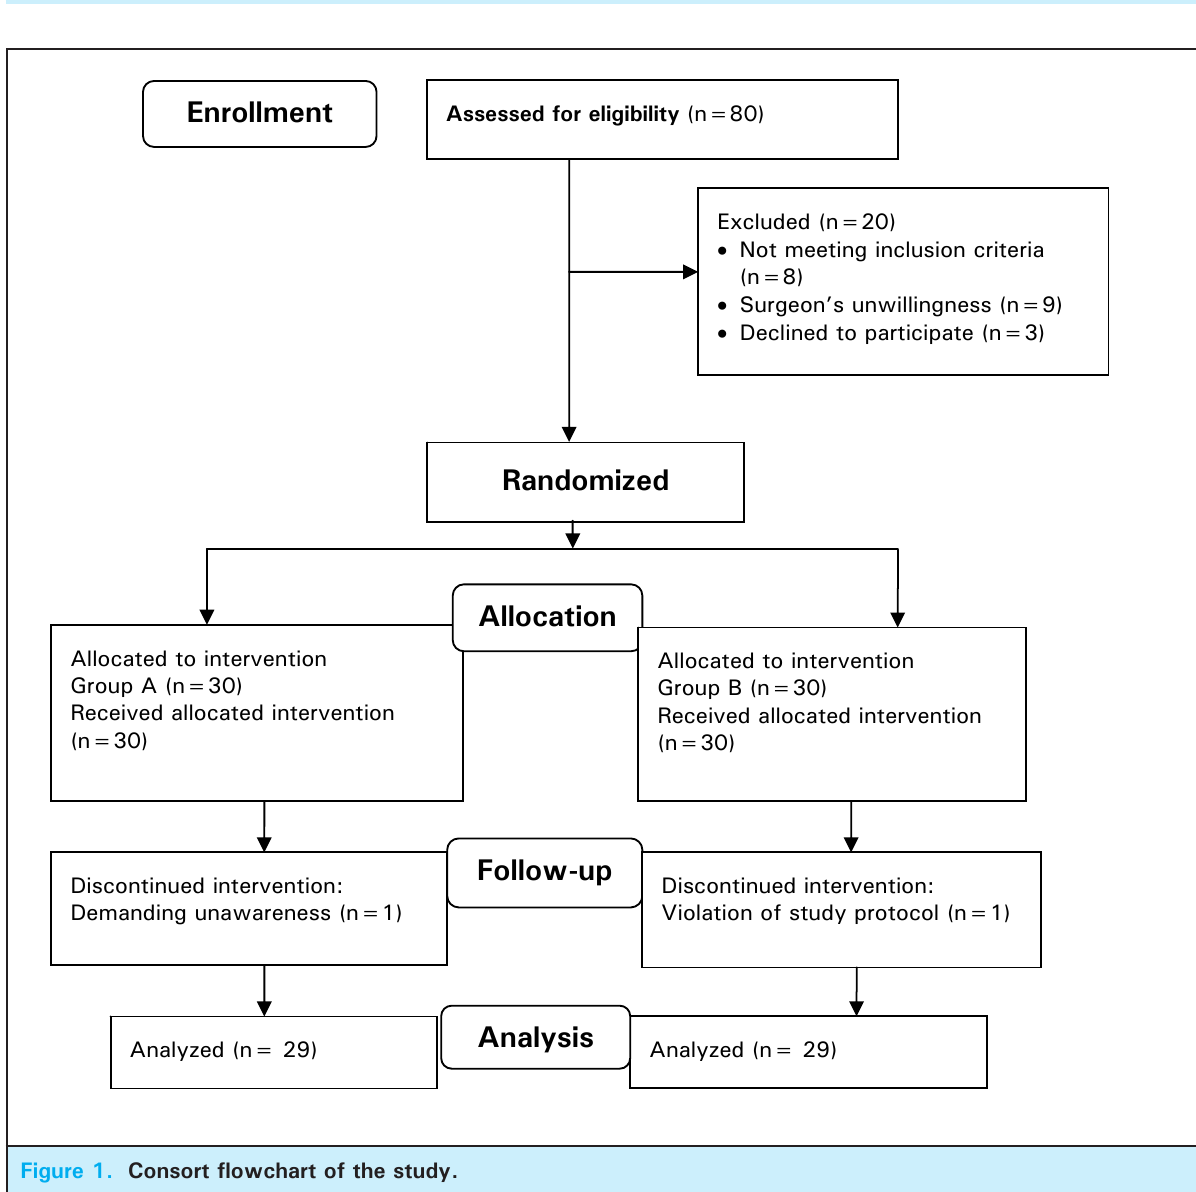
Figure 1. Consort flowchart of the study. There was no significant difference between groups in demographic and surgical characteristics (Table 1). Table 1. Demography and surgical profile.